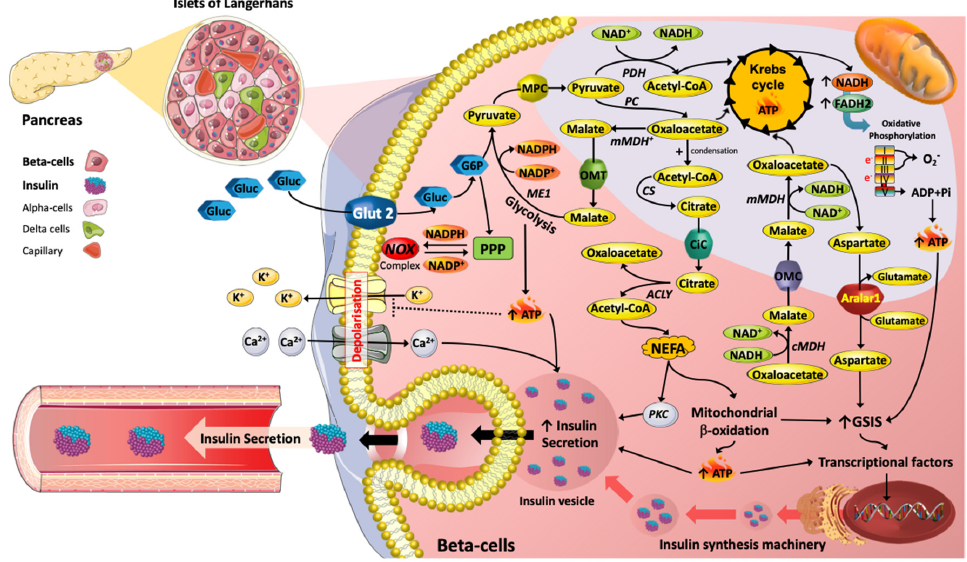
Figure 1. Metabolic reprograming mediated by nutrients with respect to insulin secretion machinery